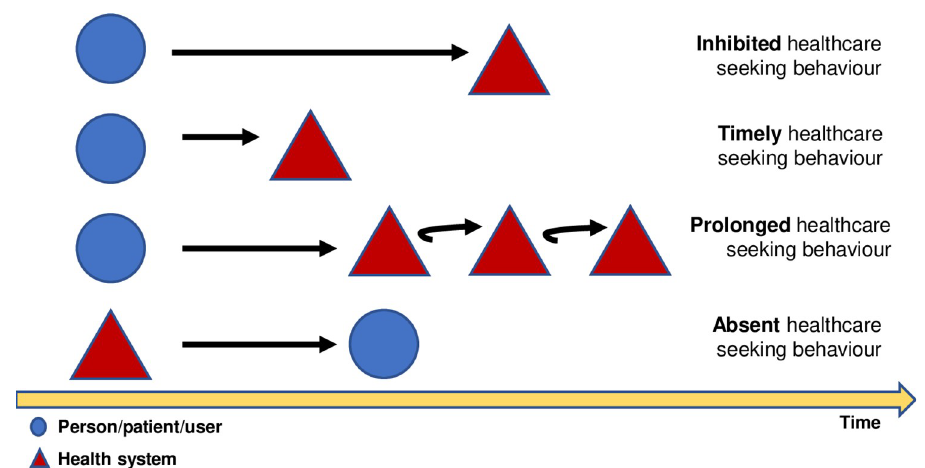
Fig 2. Four main types of “mindsets” of healthcare seeking behaviour for an episode of illness. We consider a dichotomic relationship between patient and the healthcare system influencing total time to treatment. Time to treatment is influenced by healthcare seeking behaviour pattern and healthcare system